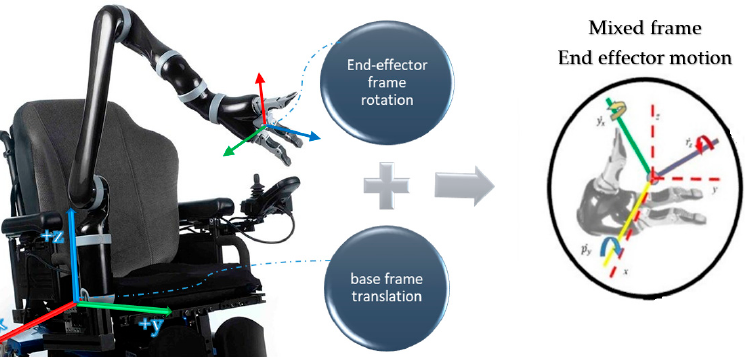
Figure 1. Mixed frame Configuration; a wheelchair-mounted assistive robotic arm Kinova ® JACO-2 6 DOF showing mix frame end-effector motion with translation w.r.t the fixed base frame and rotation expressed as the R-P-Y angles in the end-effector frame.